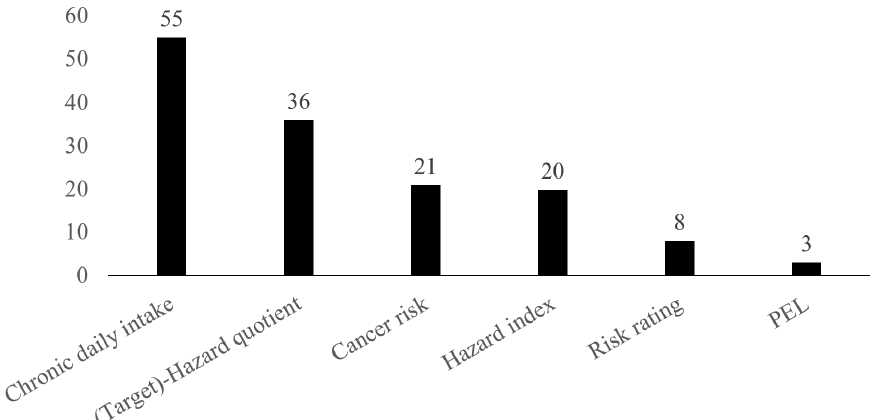
Figure 9. Health risk indices reported 46 out of 176 included studies. Figures represent the number of studies reporting each index. Note: PEL, permissible exposure limit.